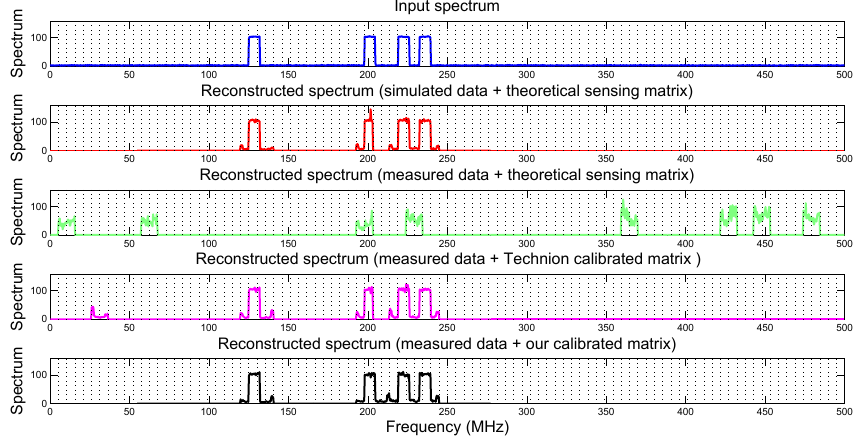
Figure 13. Comparison of reconstructed spectrum (4 transmitters, SNR = 30